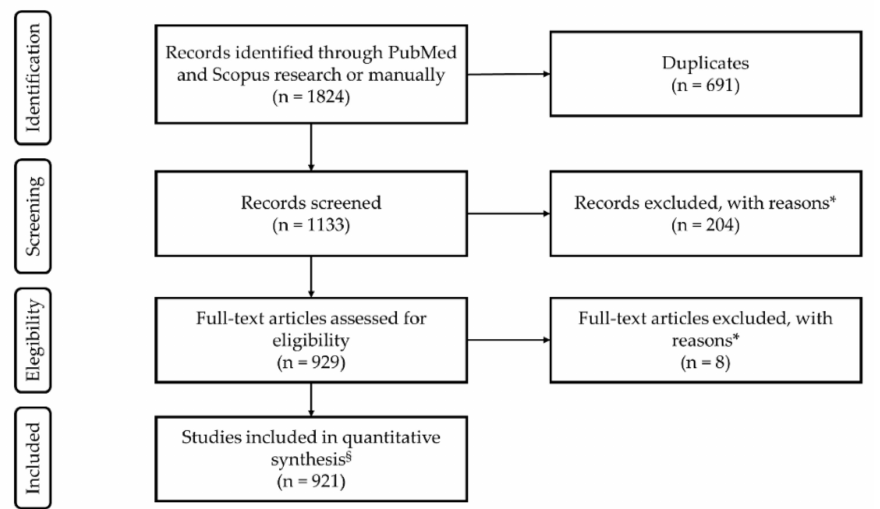
Figure 2. PRISMA flowchart diagram summarizing the study selection. (§) The list of included papers for quantitative synthesis and their classifications according to the AI subgroups (i.e., type of methods) and main aims are reported in the Supplementary Materials (Table S1). (*) The list of excluded papers from quantitative synthesis and reasons for exclusion are reported in the Supplementary Materials (Table